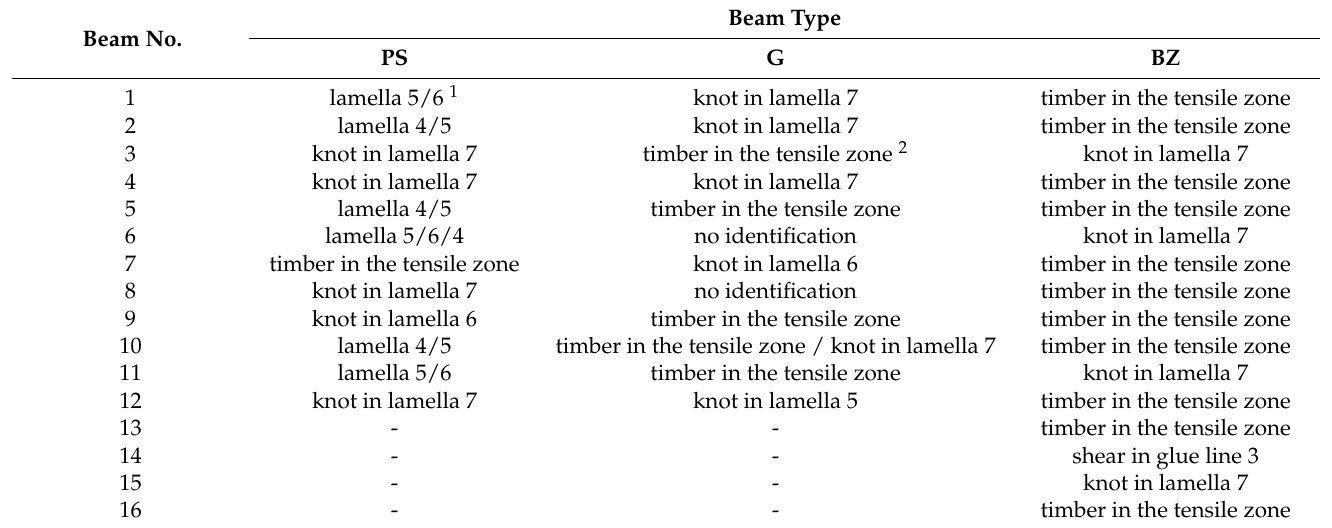
1 —shear in glue line between successive lamellas, 2 —damage to side board containing glued reinforcement (rods).